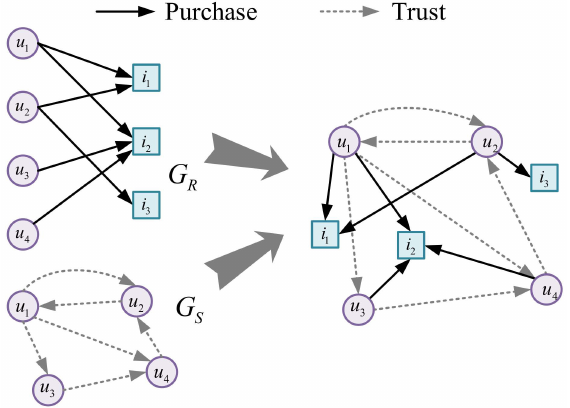
Figure 3. Illustration of a HIN recommendation